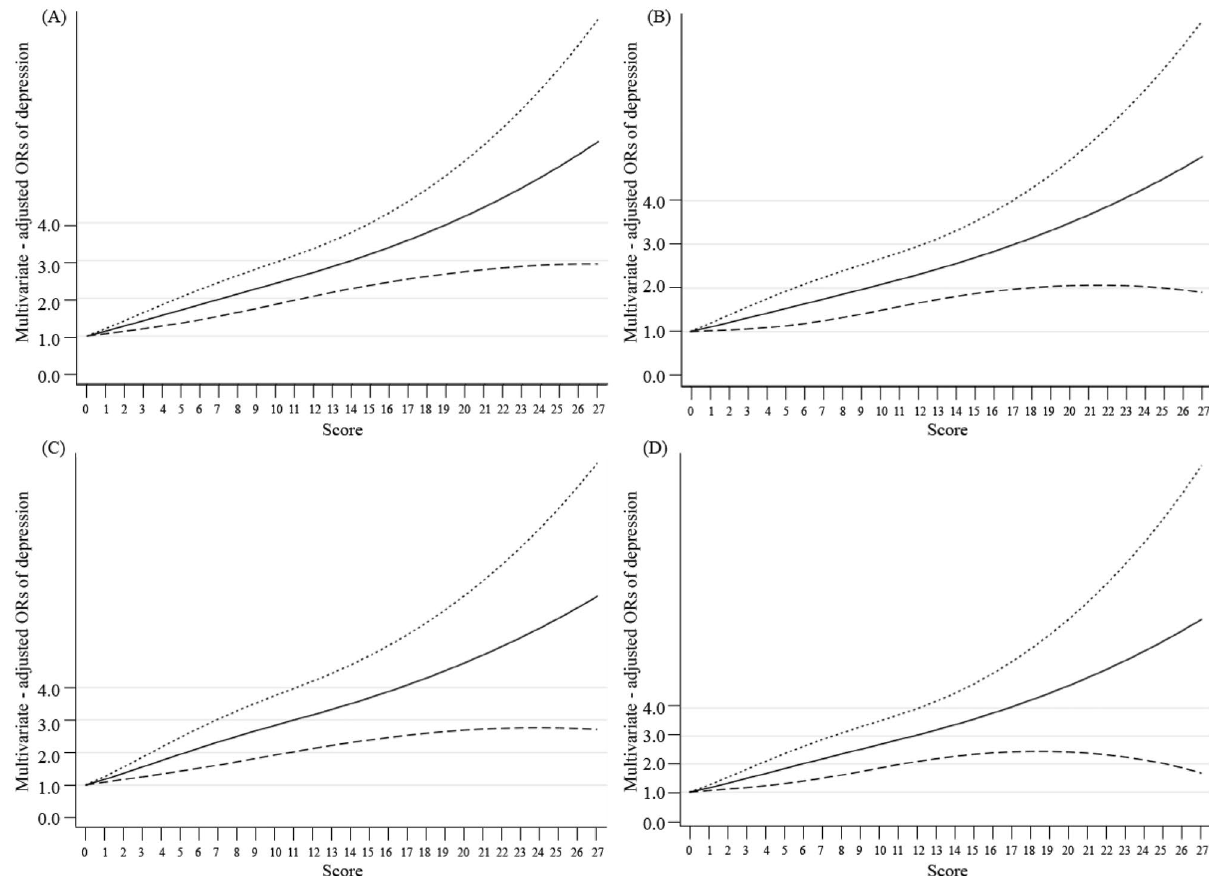
Figure 2. The dose–response relationships between PHQ scores and ischemic heart disease, coronary heart disease, heart attack, and angina pectoris. The solid line and dashed line represent the estimated ORs and its 95% CI. OR odds ratio, CI confidence intervals. ( A – D ) The outcome variables are ischemic heart disease, coronary heart disease, heart attack, and angina pectoris,